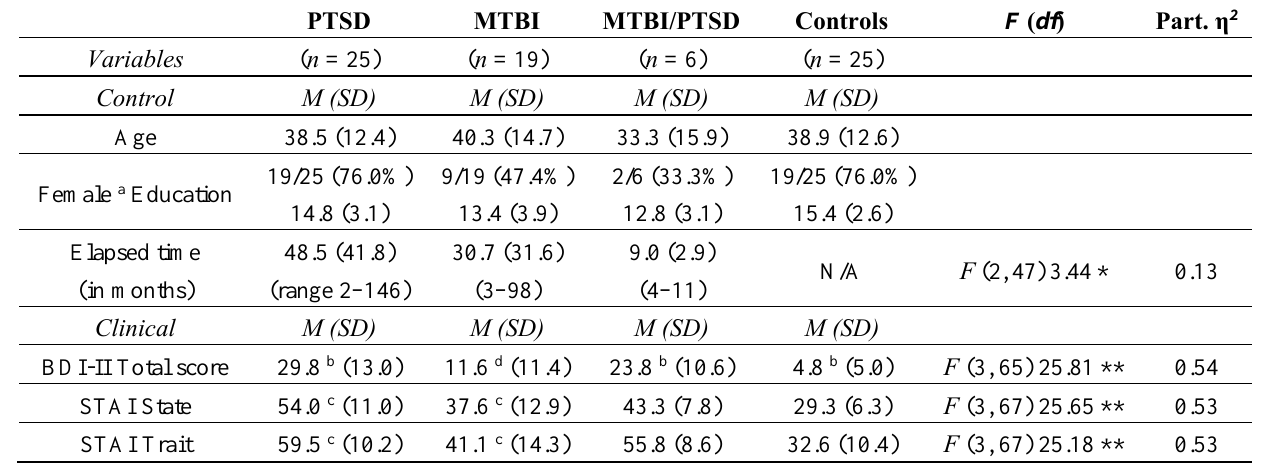
Table 1. Summary of clinical and control